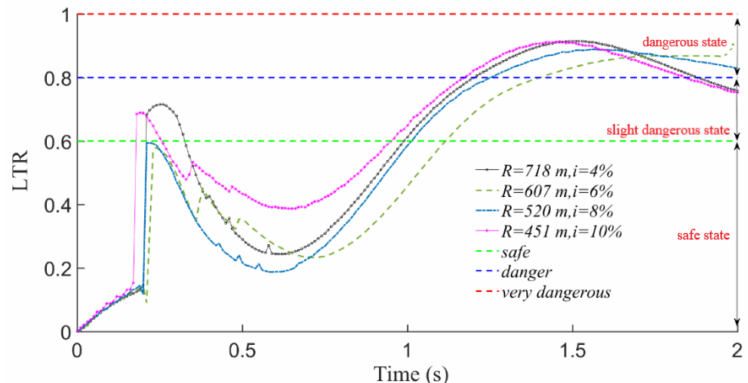
Figure 6. Simulation results of LTR at a driving speed of 120 km/h before